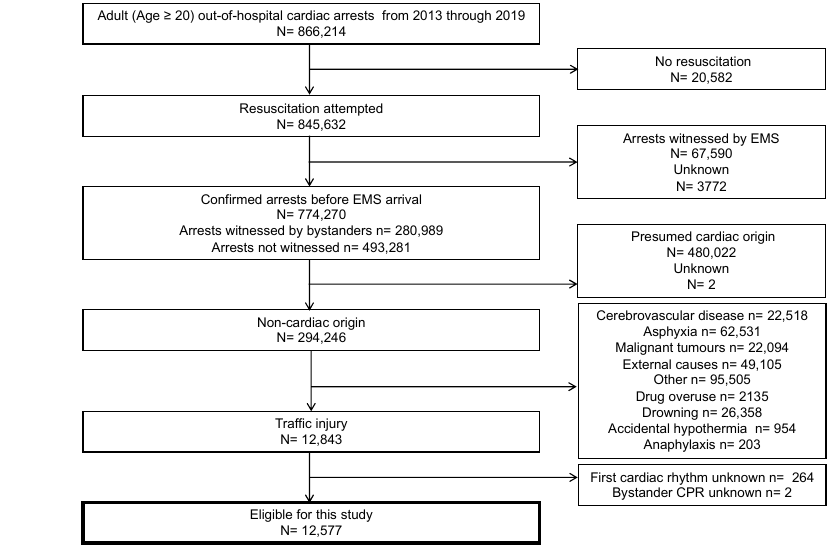
Figure 1. Flow chart of the study population.